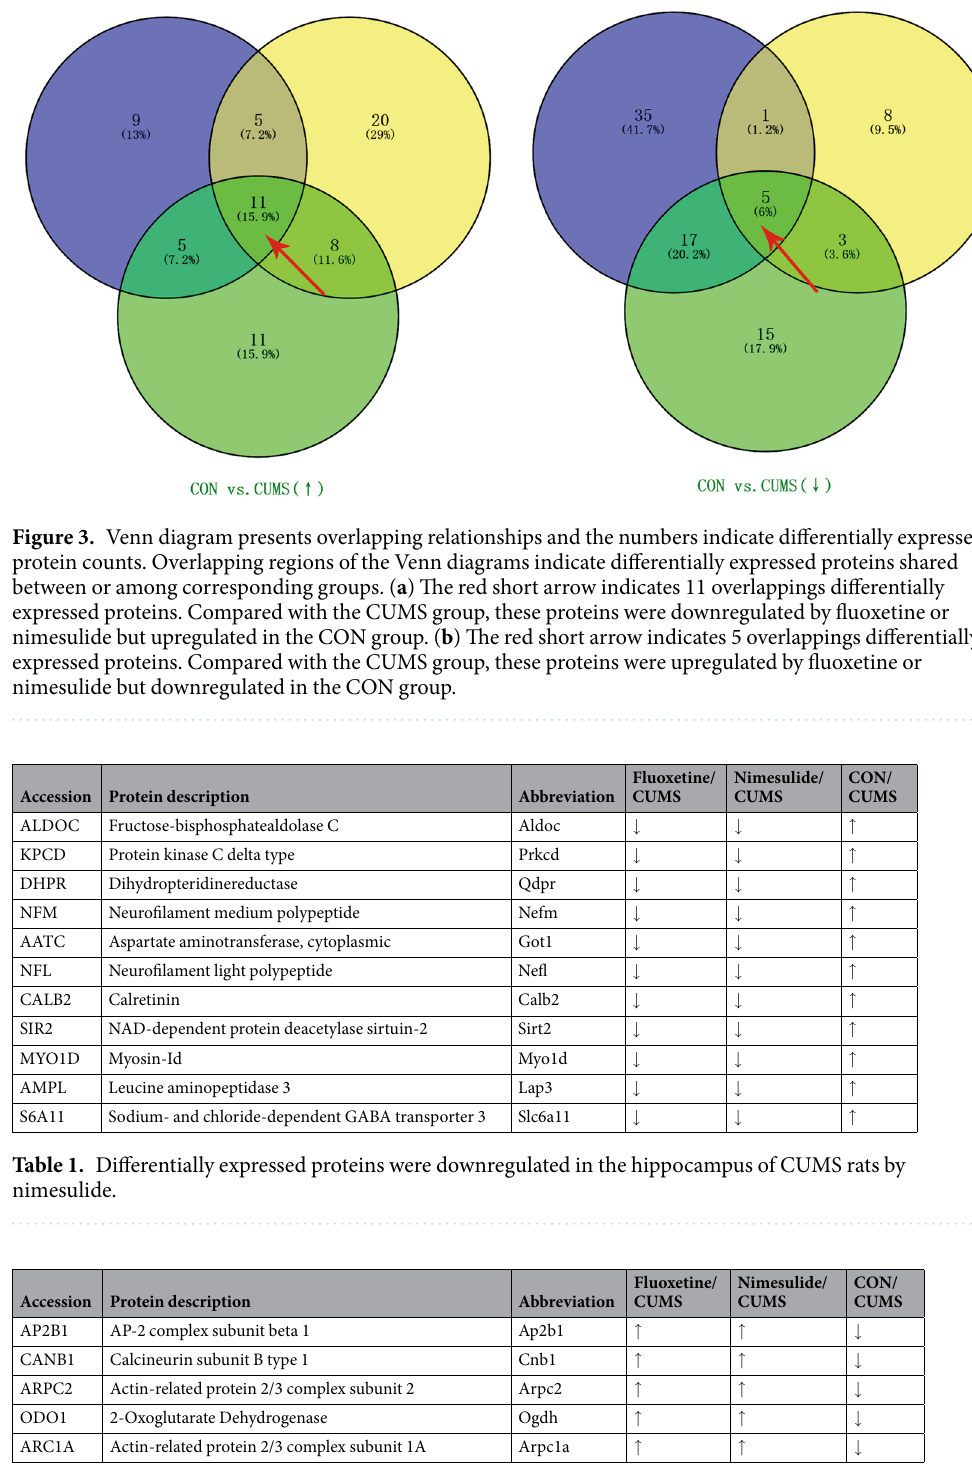
Table 2. Differentially expressed proteins were upregulated in the hippocampus of CUMS rats by